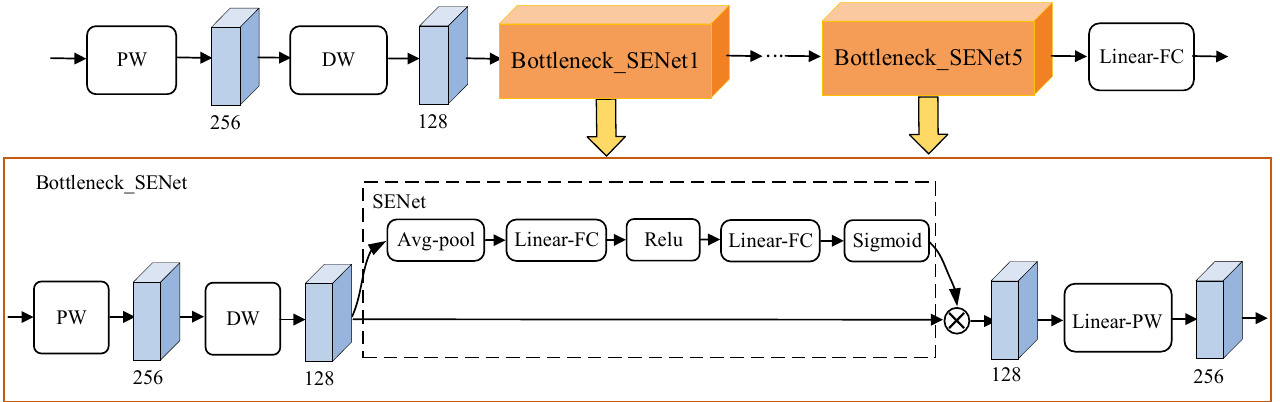
Figure 4. The architecture of feature extraction network.